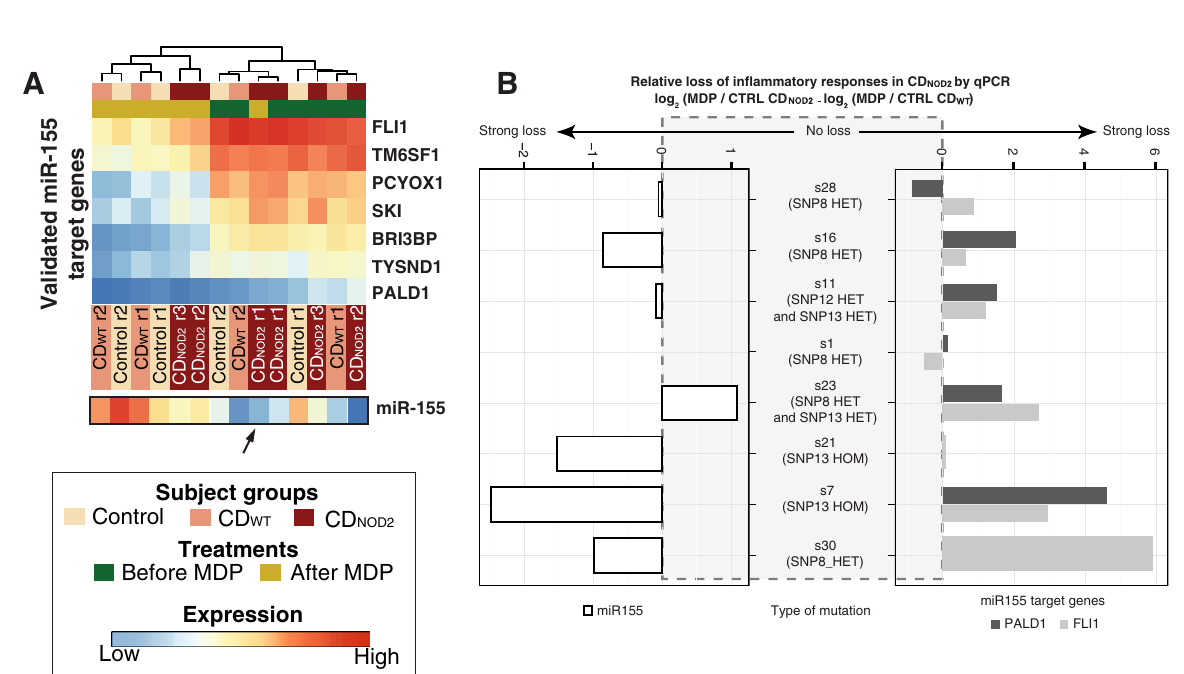
Fig. 6 Classi fi cation power and variability of miR-155 and its targets across CD NOD2 patients. a Heat map as in Fig. 2a showing the expression pattern of the seven genes interacting with miR-155 indicated in a . The expression of miR-155 in corresponding libraries is indicated below the heat map. The black arrow highlights the outlier CD NOD2 subject that shows no substantial response to MDP. b Degree of response changes of individual CD NOD2 patients compared to the average response of CD WT patients from the exploratory cohort on miR-155 level ( left panel) and two selected miR-155 target genes ( PALD and FLI1 , right panel). The plot follows the same conventions as Fig.